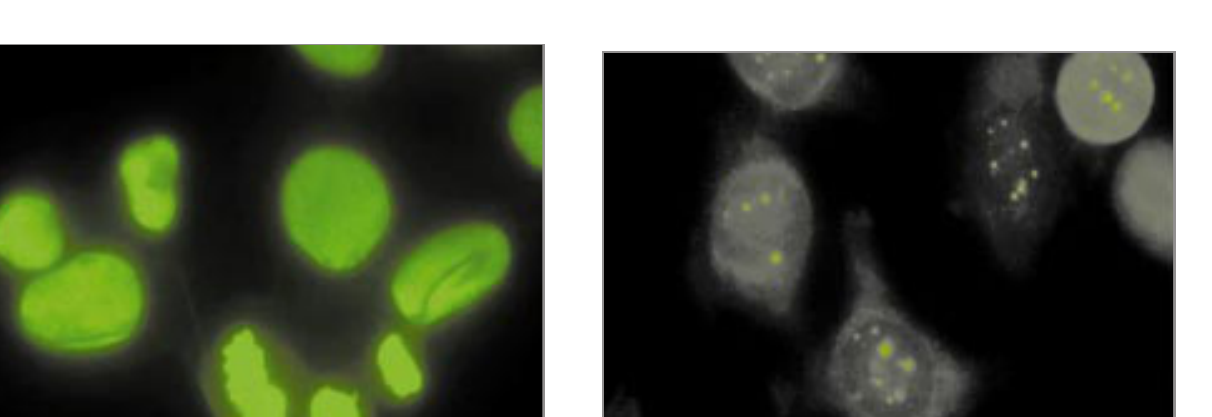
Figura 2 – Nuclear tipo membrana nuclear